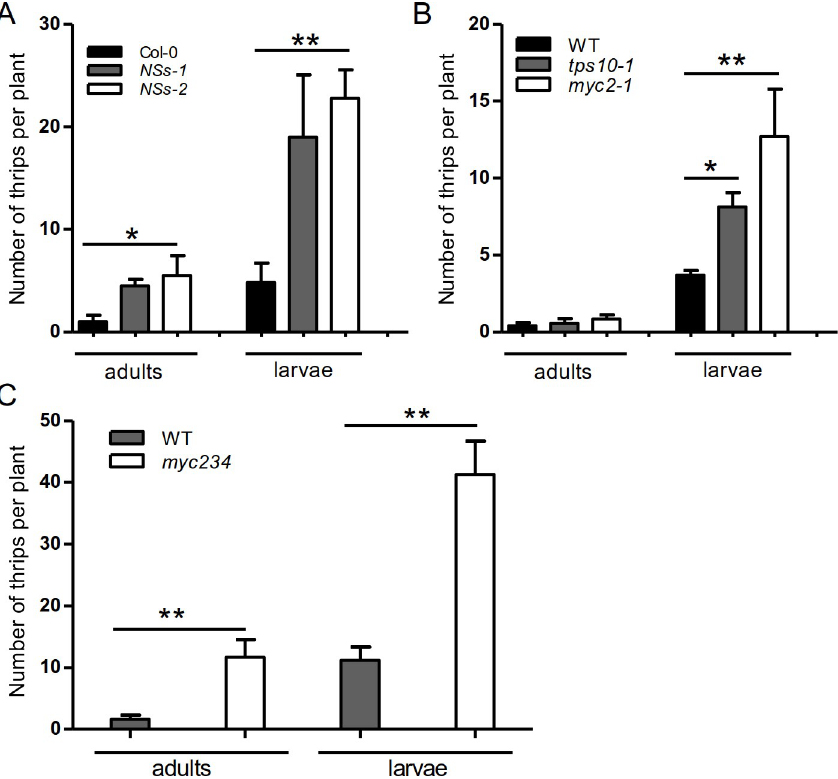
Fig 6. NSs promotes WFT performance by targeting MYC-mediated host defense. (A-C) Effects of different genes on the number of WFT offspring. Seven adult females fed on each three-week-old Arabidopsis line. After 2 weeks, new larvae and adults were counted. Values are means ± SE, n = 8. � P < 0.05, �� P < 0.01, Student’s t